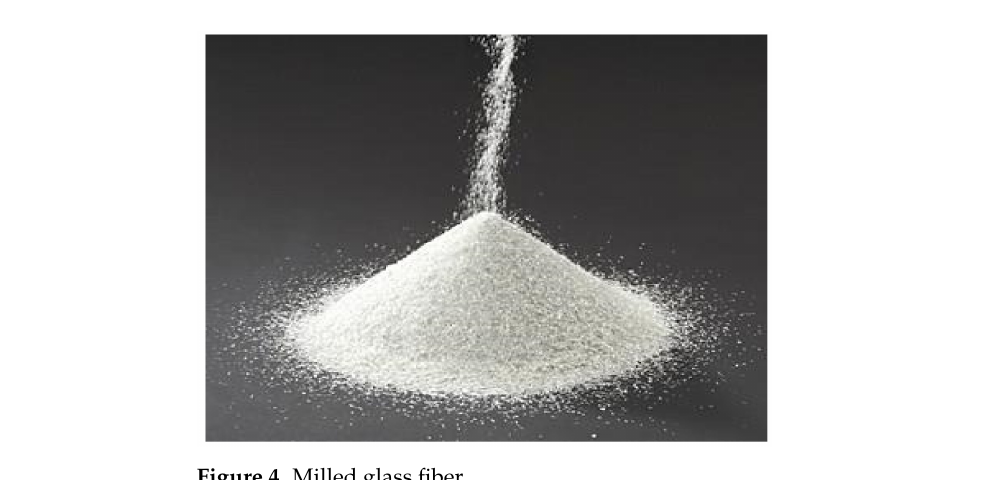
Figure 4. Milled glass fiber. Table 1. Physical properties of GFRPU according to glass fiber content.